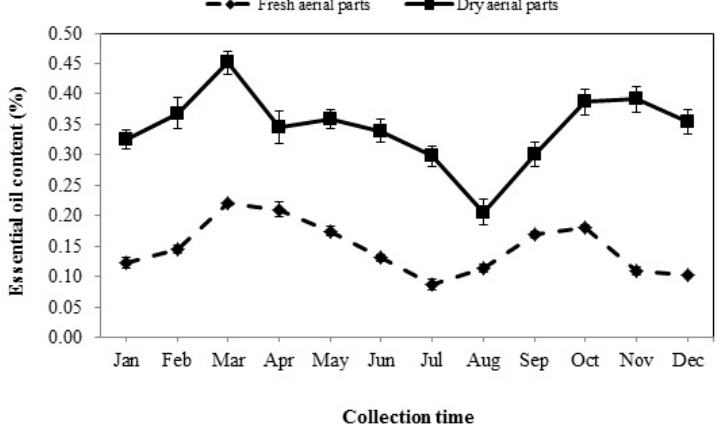
Figure 1. The seasonal variation of the essential oil content extracted from fresh and dried aerial parts of Arabian lilac. Values are the mean ± standard deviation (SD) of three replications ( n = 3).